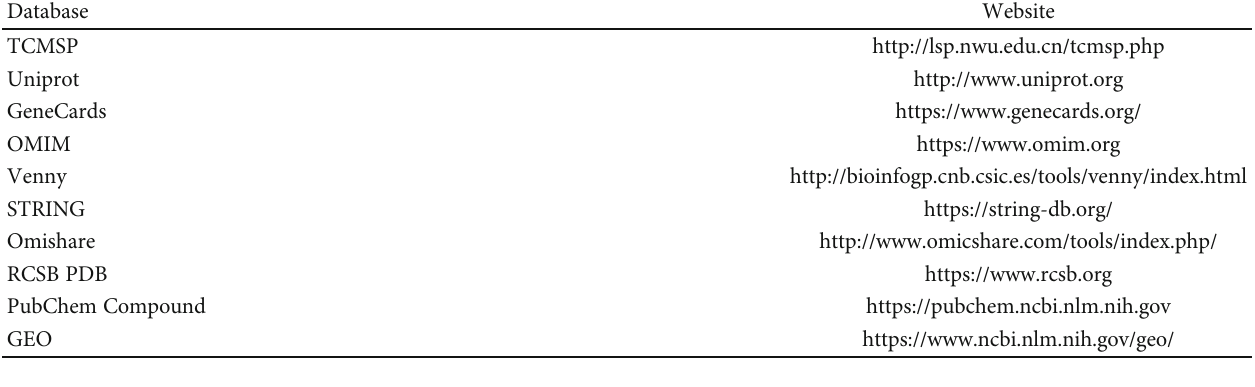
Table 1: Database and website.